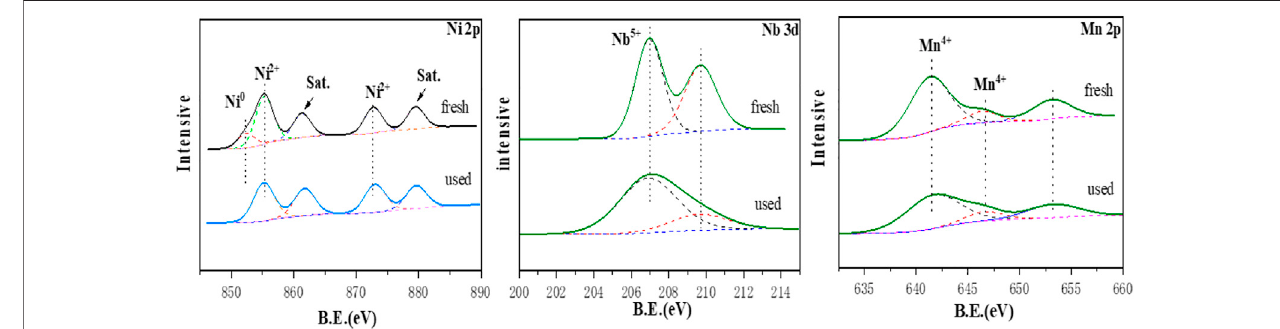
FIGURE 5 | XPS analysis of the reduced and used Ni – Mn/Nb 2 O 5 catalysts.